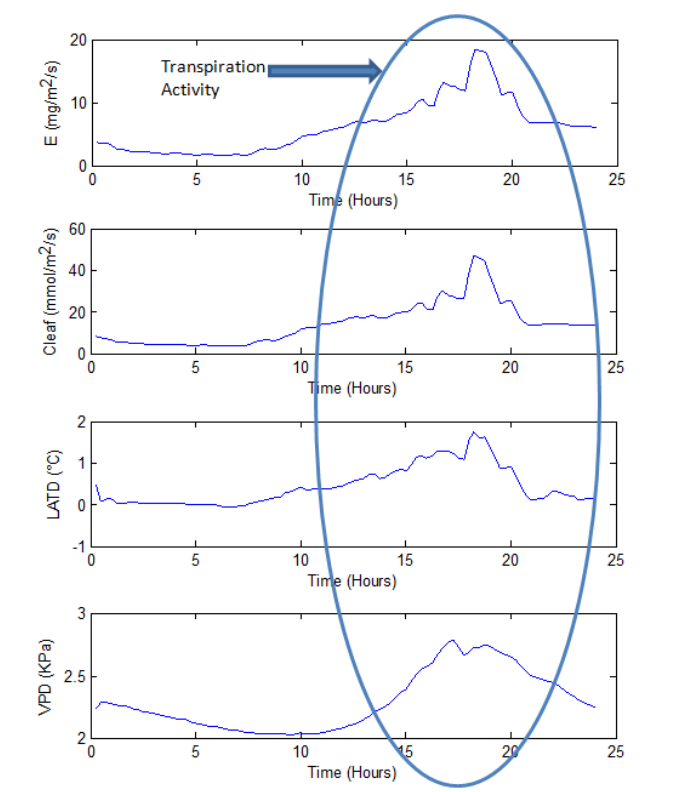
Figure 11. Transpiration dynamics